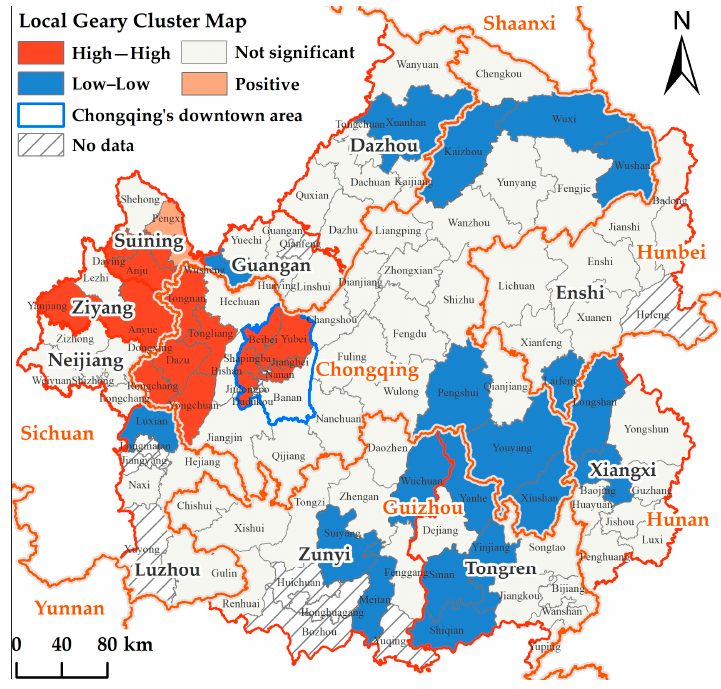
Figure 5. Geary cluster map of farmland transfer rents.